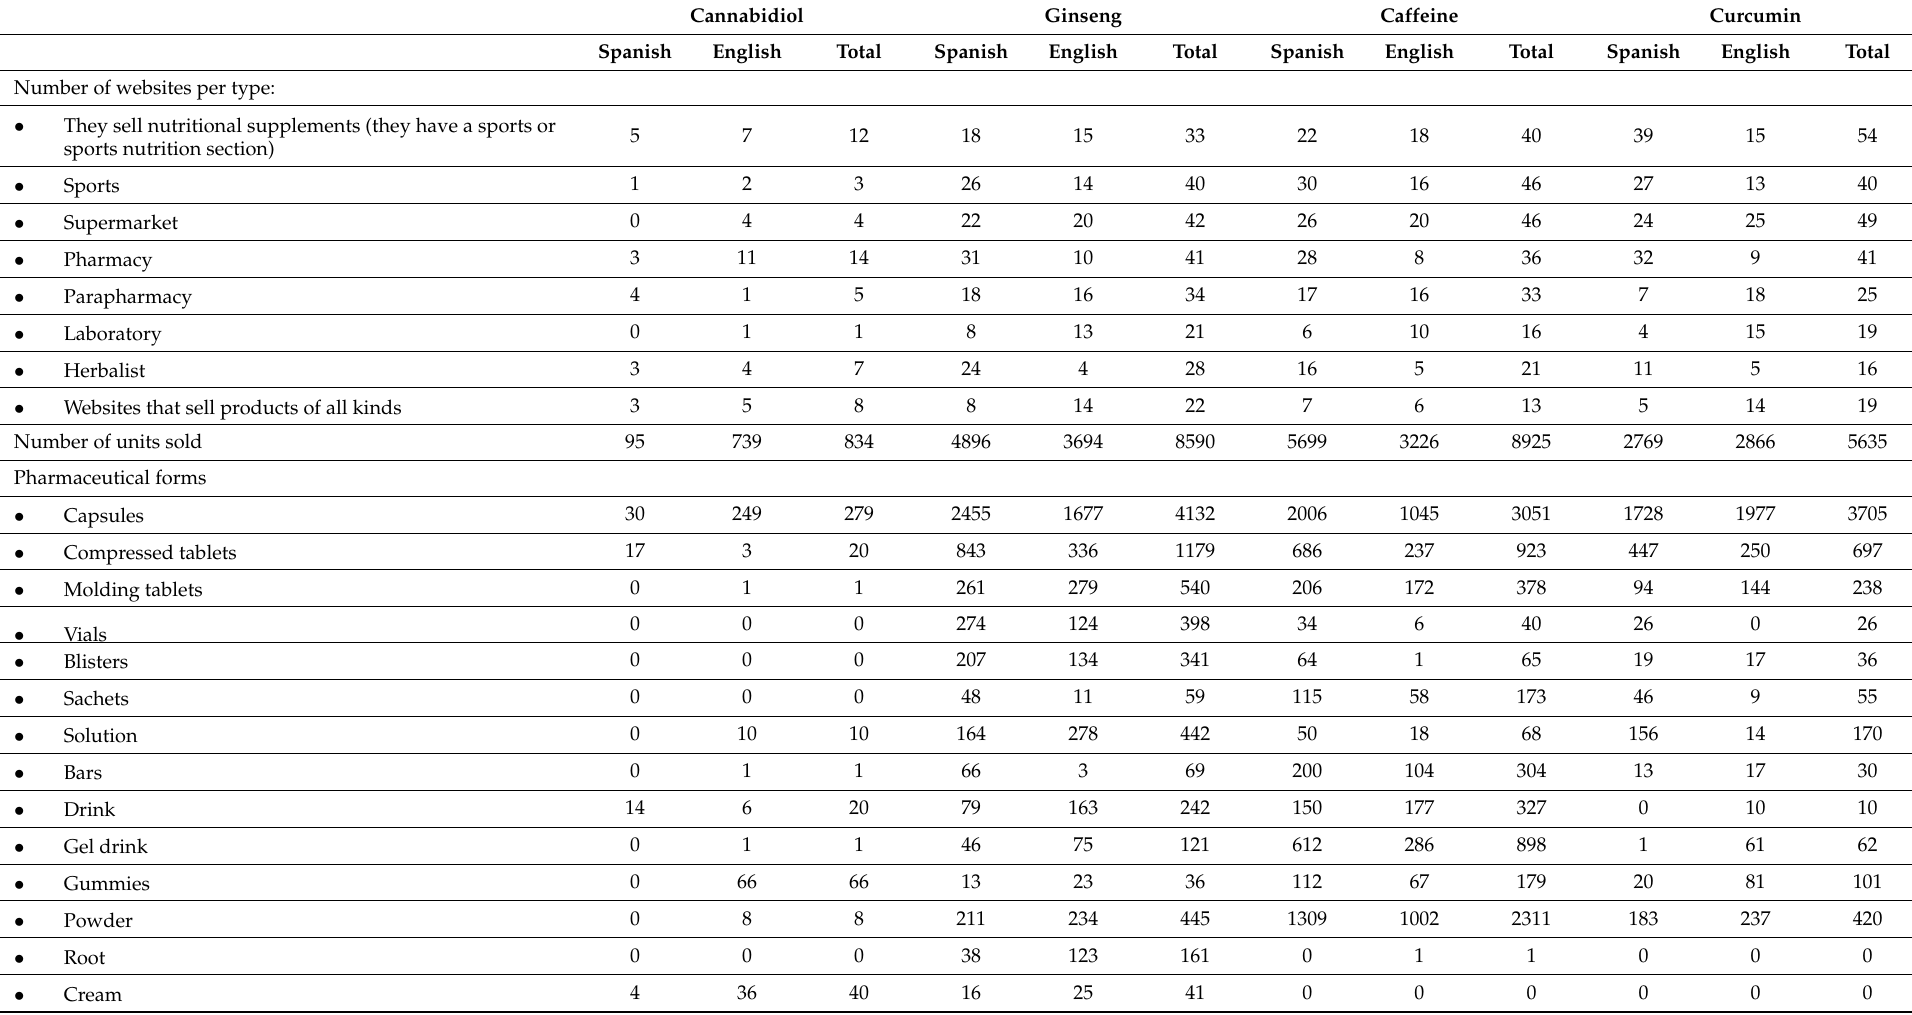
Table 2. Characteristics of the offer for each compound in the websites